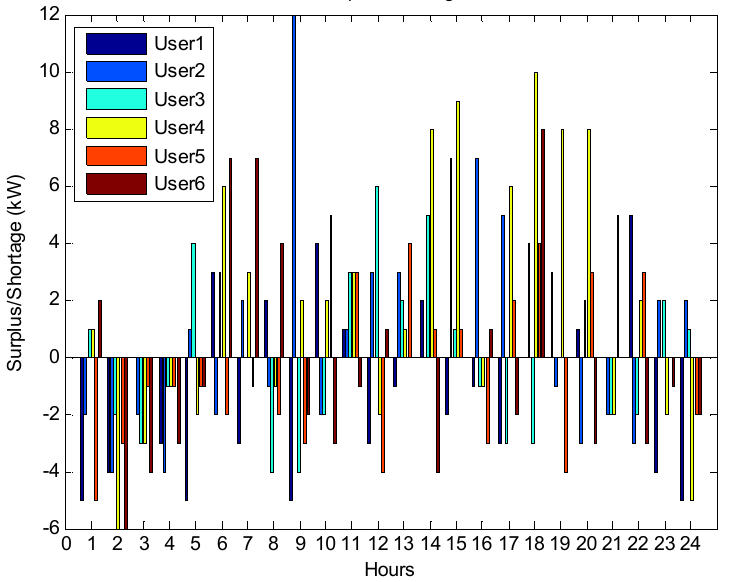
Figure 3. Shortage/surplus energy before optimization.